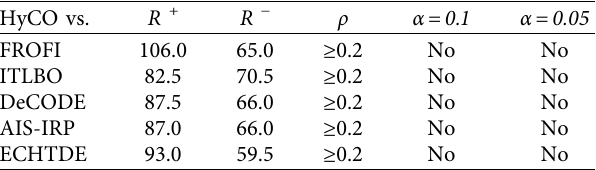
Table 4: Results of HyCO and other compared algorithms by the multiple-problem Wilcoxon’s test on 18 COPs with 10d from CEC